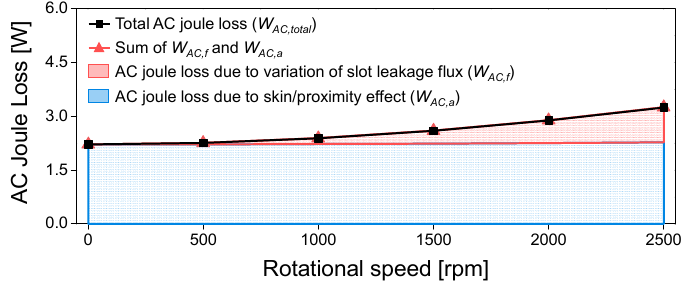
Figure 4. Principle of frozen permeability method for separating AC Joule loss.